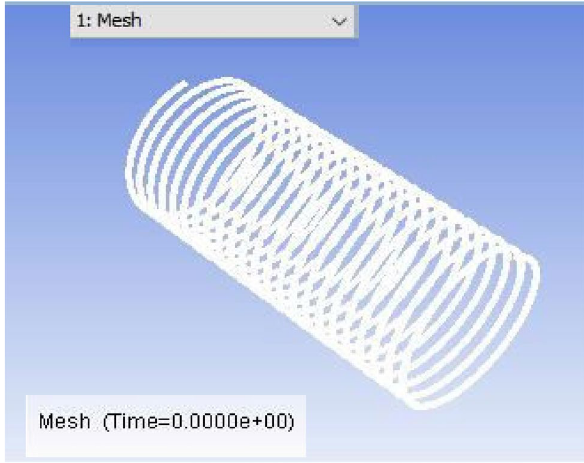
Figure 6. The fluent grid model.